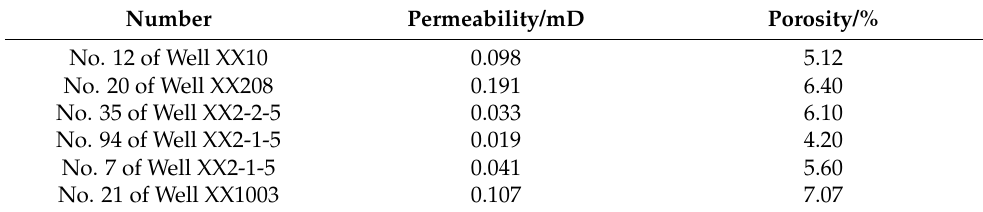
Table 2. Basic physical parameters of cores.